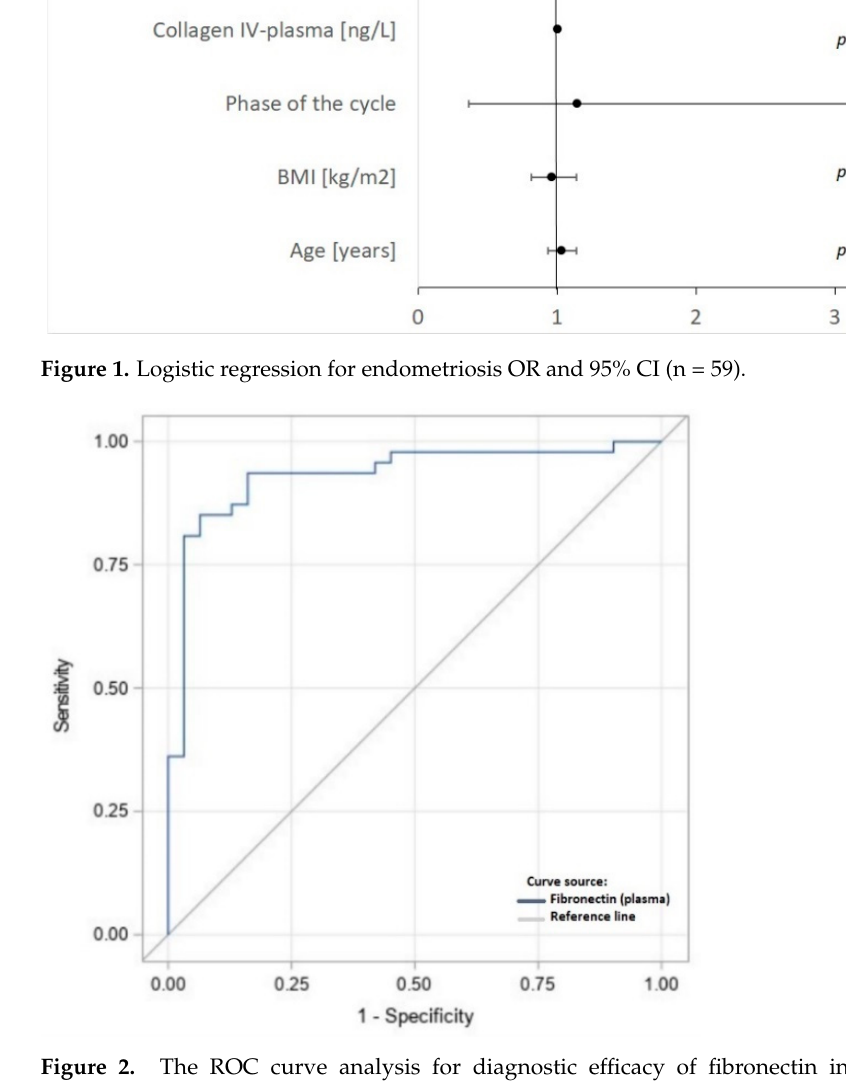
Figure 3. The ROC curve analysis for diagnostic efficacy of fibronectin in plasma for endometriosis. Figure 4. The ROC curve analysis for diagnostic efficacy of both fibronectin in plasma and peritoneal fluid for endometriosis.